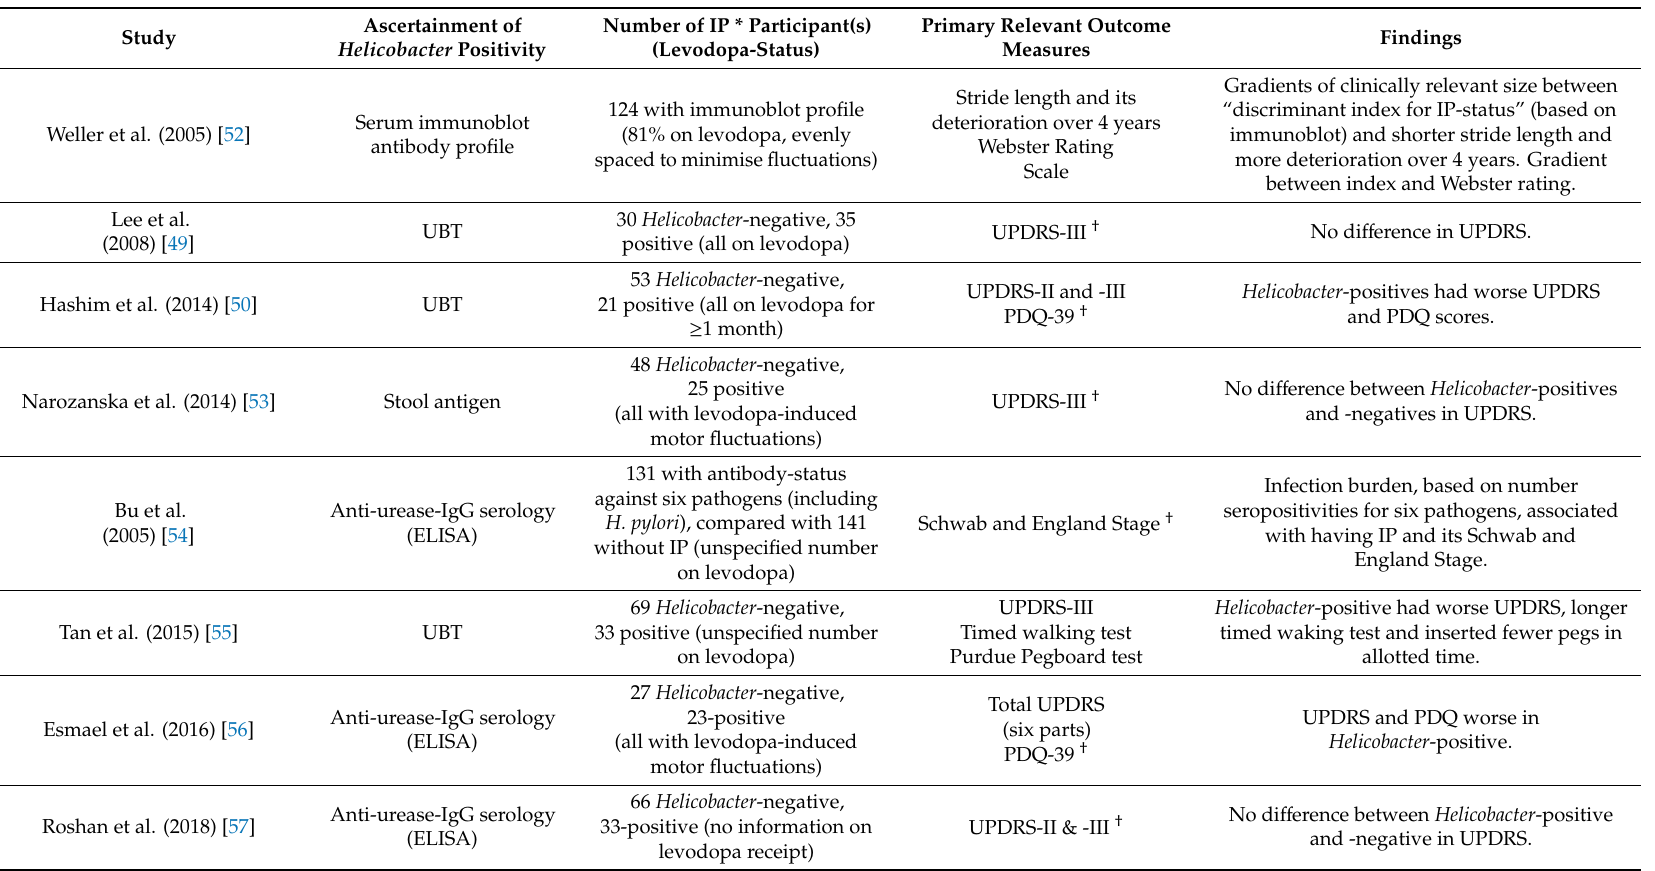
Table 3. Cross-sectional observational studies of relationship of Helicobacter -status to motor severity and hypokinesia within idiopathic parkinsonism. Ascertainment of Number of IP * Participant(s) Primary Relevant Outcome Study Findings Helicobacter Positivity (Levodopa-Status) Measures Gradients of clinically relevant size between Stride length and its “discriminant index for IP-status” (based on Serum immunoblot deterioration over 4 years Weller et al. (2005) [52] immunoblot) and shorter stride length and antibody profile Webster Rating spaced to minimise fluctuations) more deterioration over 4 years. Scale